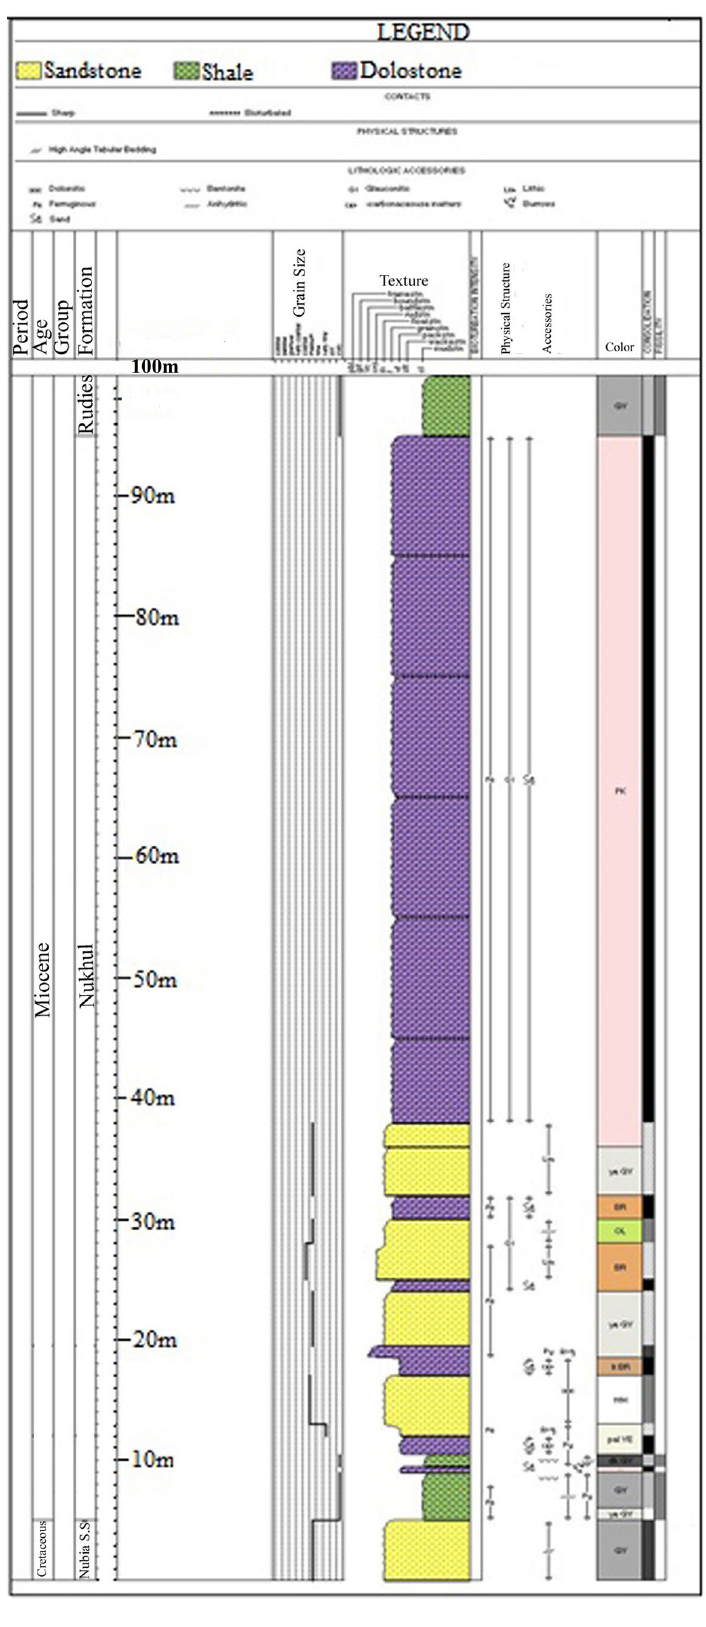
Fig. 4 Lithostratigraphy of the studied Nukhul Formation at Gebel